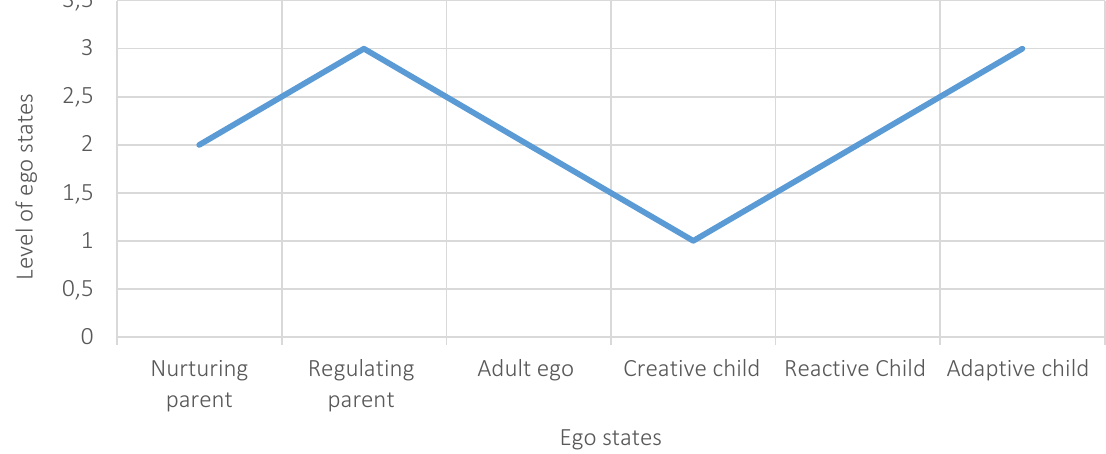
Figure 2. Level of ego